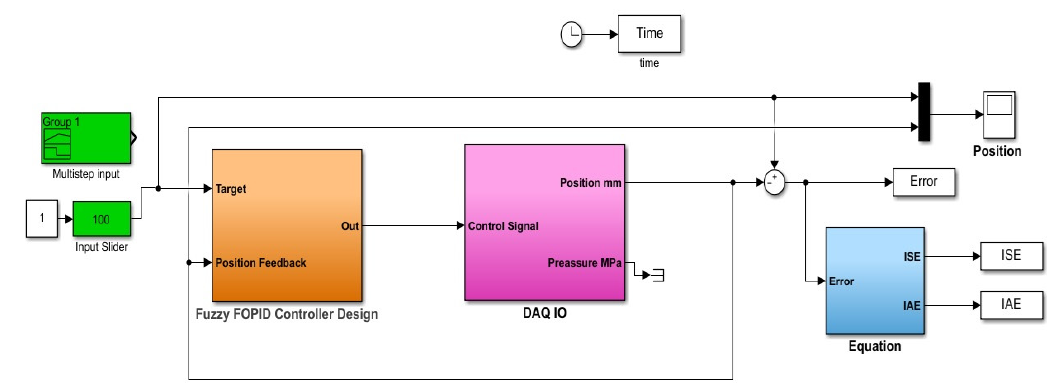
Figure 12. Simulink diagram for real-time experiment.